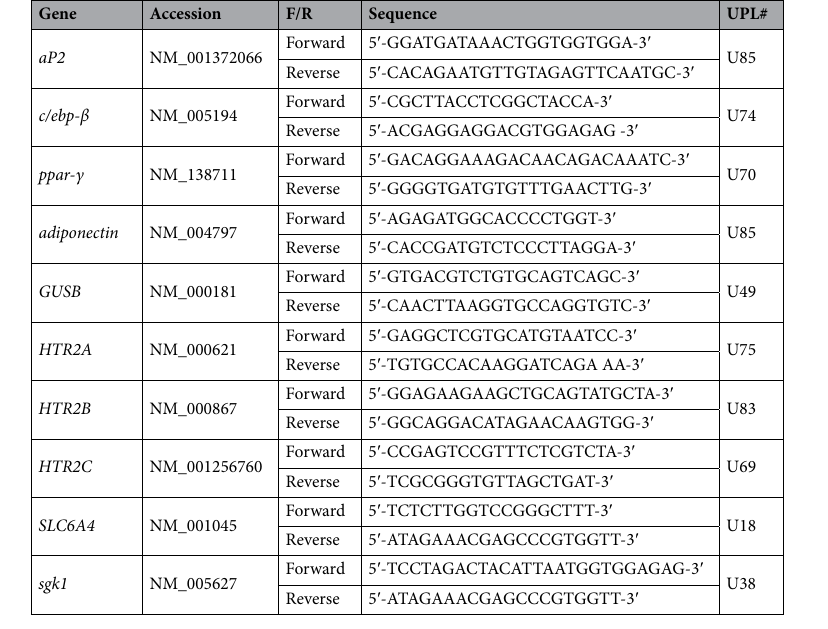
Table 1. Gene and primer/probe